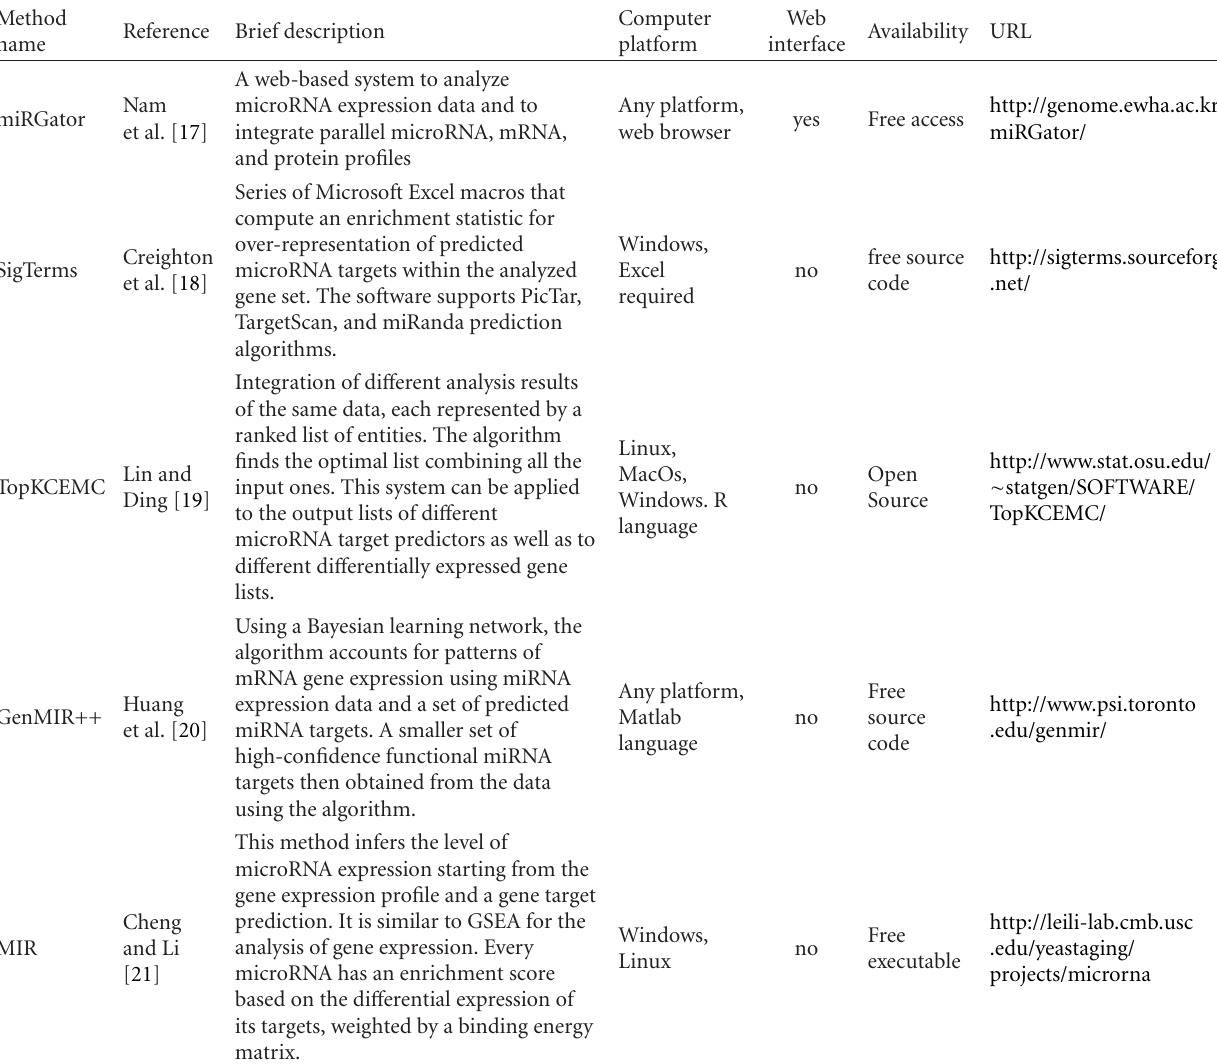
Table 2: Algorithms and software tools specifically developed for functional interpretation of miRNA expression data, inference of miRNA gene regulation from mRNA trascriptomic profiles, combination of parallel mRNA and miRNA expression